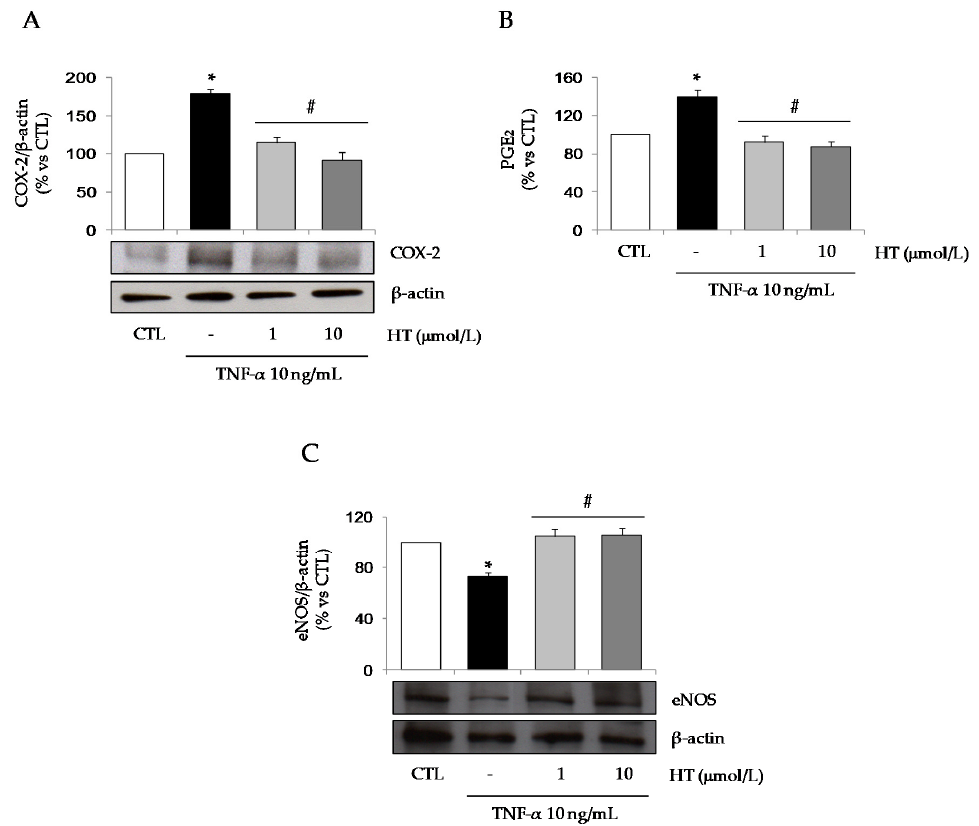
Figure 7. Effect of HT on the intracellular levels of COX-2 and eNOS. SGBS cells were treated with 1 and 10 μ mol/L HT and then stimulated with 10 ng/mL TNF- α for 18 h. COX-2 ( A ) and eNOS ( C ) intracellular protein levels were determined by Western analysis using specific antibodies. COX-2 and eNOS band intensities were normalized to β -actin, and are expressed as percent of untreated control (CTL). ( B ) Cell culture media were collected to assess the production of COX-2 product PGE 2 . Data are means ± SD (n = 3). * p < 0.05 vs CTL. # p < 0.05 vs TNF- α alone. 3.4. HT Prevents TNF- α -Induced ROS Production and NF- κ B Activation In search of the upstream site of interference by HT with the signaling pathway(s) mediating modulation of inflammatory gene expression in adipocytes, and given the role of the redox-sensitive transcription factor NF- κ B in orchestrating inflammatory transcriptional programs in adipocyte dysfunction [40], we examined the HT effect on intracellular ROS production and the consequent activation of NF- κ B under TNF- α stimulation. Basal ROS production, as assessed by dichlorofluorescein fluorescence, was significantly increased— by about 35%—by TNF- α (Figure 8A). Pre-incubation of adipocytes with 1 and 10 μ mol/L HT before cytokine stimulation almost completely abrogated the induced production of ROS. Correspondingly, HT was able to prevent TNF- α -induced activation of NF- κ B as measured by the DNA binding activity of the NF- κ B p65 subunit (by 20% ± 5% for 1 μ mol/L HT and 30% ± 7% for 10 μ mol/L HT compared with TNF- α alone) (Figure 8B).